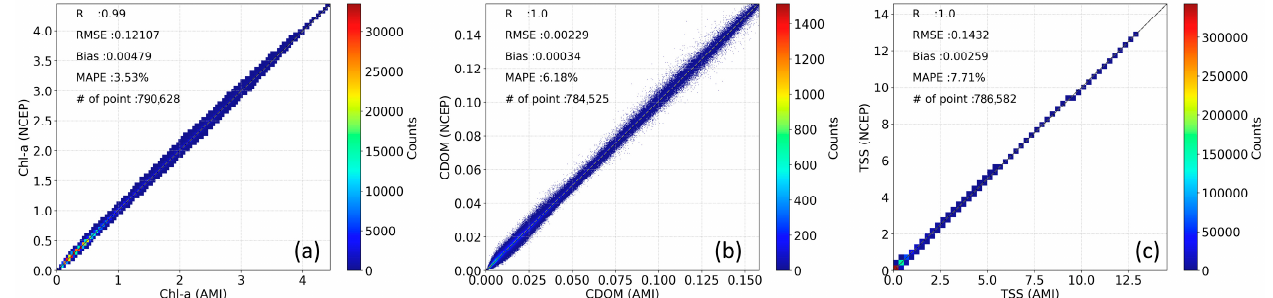
Figure 7. Same with Figure 6 but for ocean-color product: ( a ) chlorophyll-a concentration, ( b ) colored dissolved organic matter, ( c ) total suspended sediment.